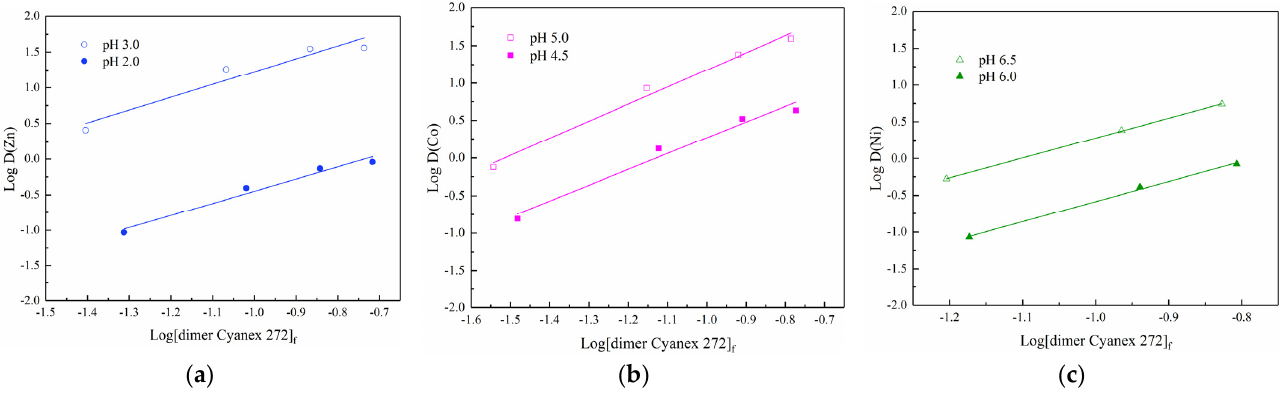
Figure 2. The relationship of Log D ( M ) against Log [dimer Cyanex 272] f . ( a ) Log D(Zn)-Log[dimer Cyanex 272], ( b ) Log D(Zn)-Log[dimer Cyanex 272], ( c ) Log D(Zn)-Log[dimer Cyanex 272].